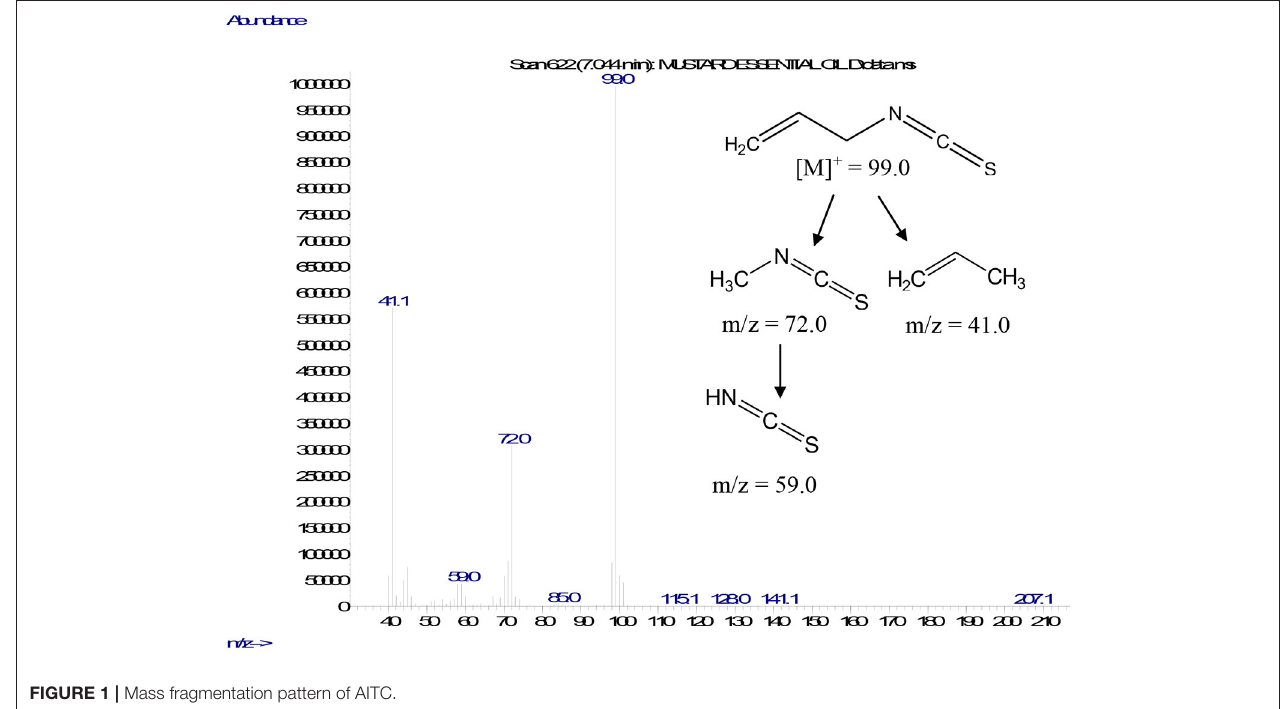
FIGURE 1 | Mass fragmentation pattern of AITC.